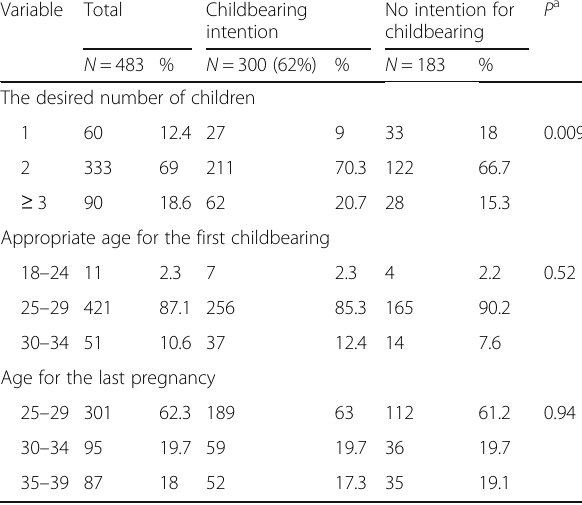
Table 2 Women preferences for the number of, and the time for having their